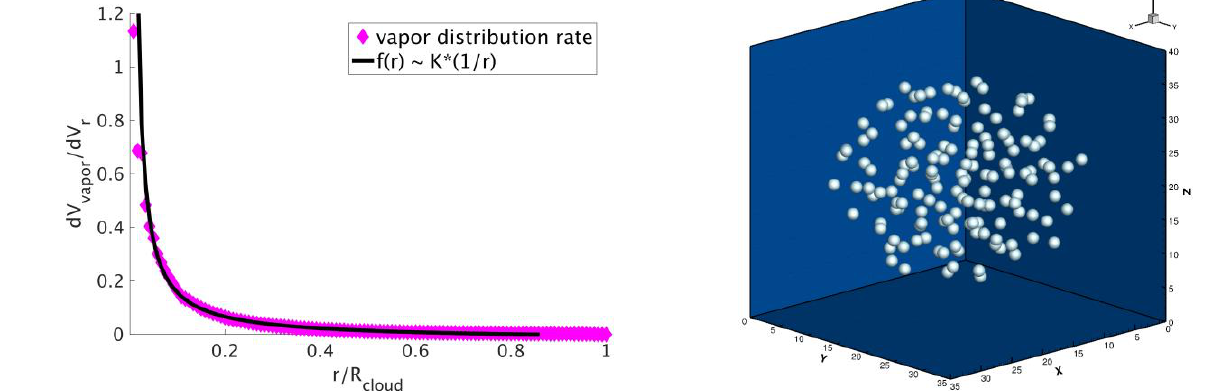
Fig. 1: Random bubble distribution of 100.000 bubbles in comparison with the desired distribution law ~ K/r . The cloud interaction parameter is β = 11